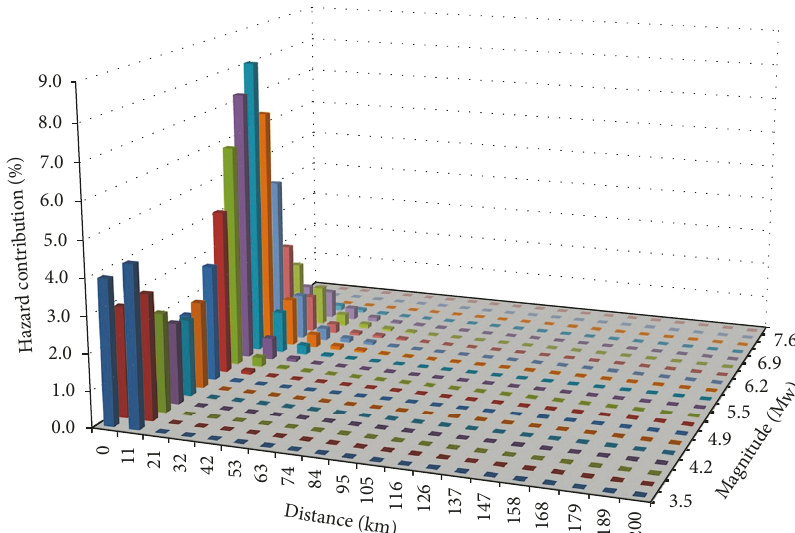
Figure 1: Magnitude-distance deaggregation for 10 −4 /a level peak ground acceleration.